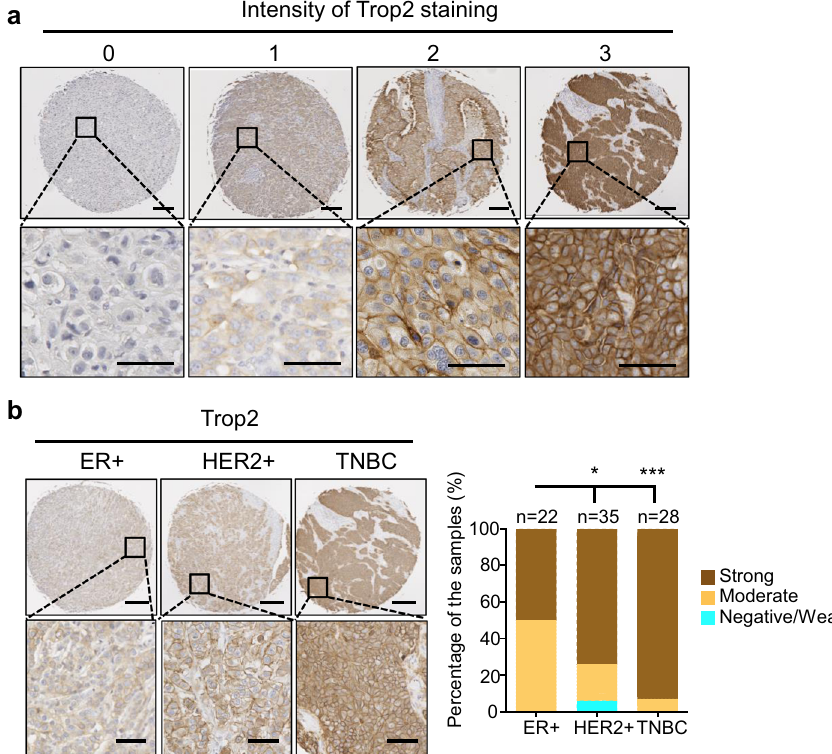
Fig. 1 Trop2 is highly expressed in breast cancer. a Representative images of Trop2 staining intensity scores. Trop2 staining intensity is scored from 0 to 3. Scale bar represents 250 µm (upper panel) and 50 µm (lower panel). b Trop2 IHC staining on TMA including ER + ( n = 22), HER2 + ( n = 35), and TNBC ( n = 28) tissue samples. Representative images of ER + , HER2 + , and TNBC samples (left) and Trop2 staining intensity distribution in ER + , HER2 + , TNBC samples as percentages are demonstrated (right). Scale bar represents 250 and 50 µm for upper and lower panels. The statistical signi fi cance of the differences between population proportions was calculated by the normal distribution N (0,1) of the Z -score. Error bars represent standard deviation (SD). * P < 0.05, *** P <